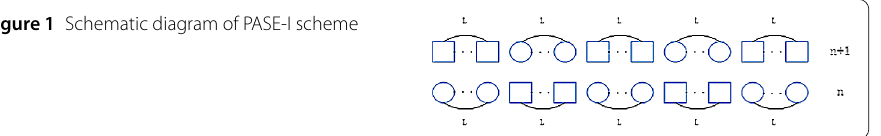
Figure 1 Schematic diagram of PASE-I